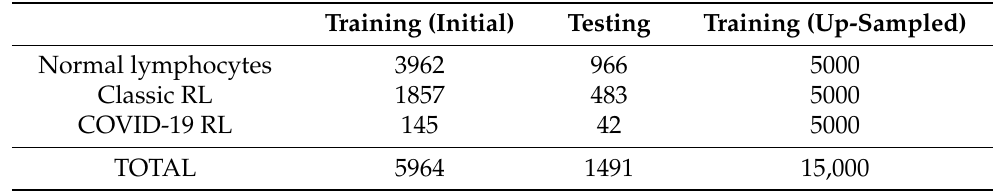
Table 4. Image datasets used for training and